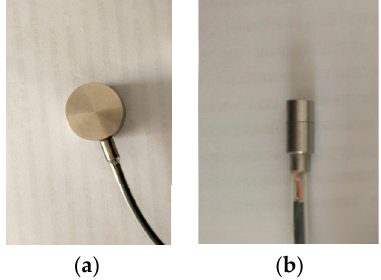
Figure 4. Picture of miniature silicon piezoresistive pressure sensor: ( a ) Earth pressure sensor and ( b ) pore water pressure sensor.